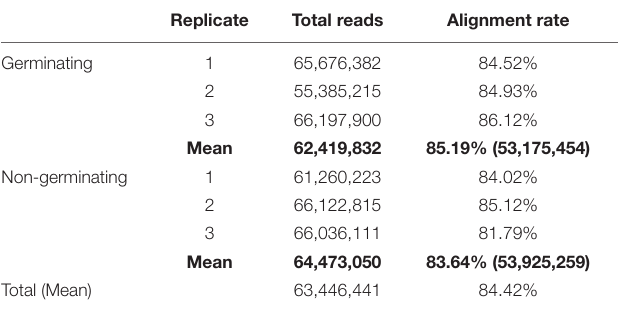
TABLE 1 | Summary of RNA sequencing raw and alignment data in million reads from six RNA libraries of germinating and non-germinating spores of S. subterranea